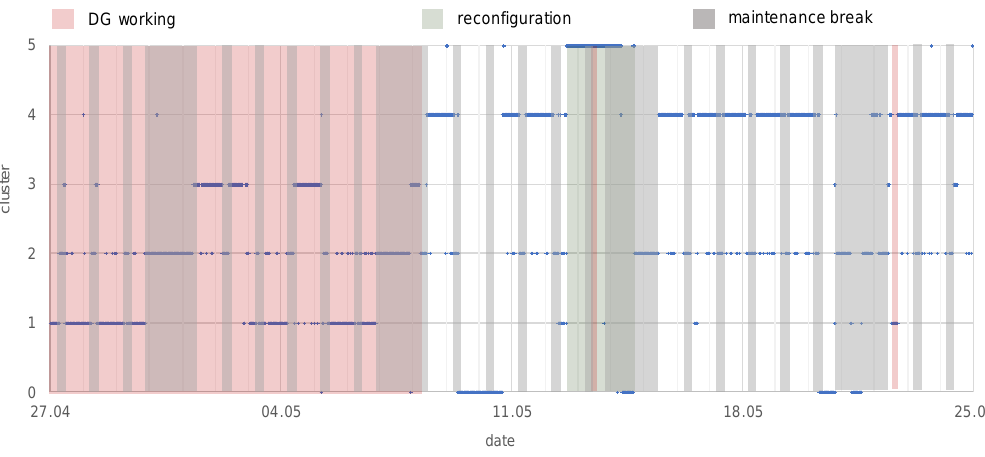
Figure 8. Cluster analysis results for the final number of clusters equal to 5.